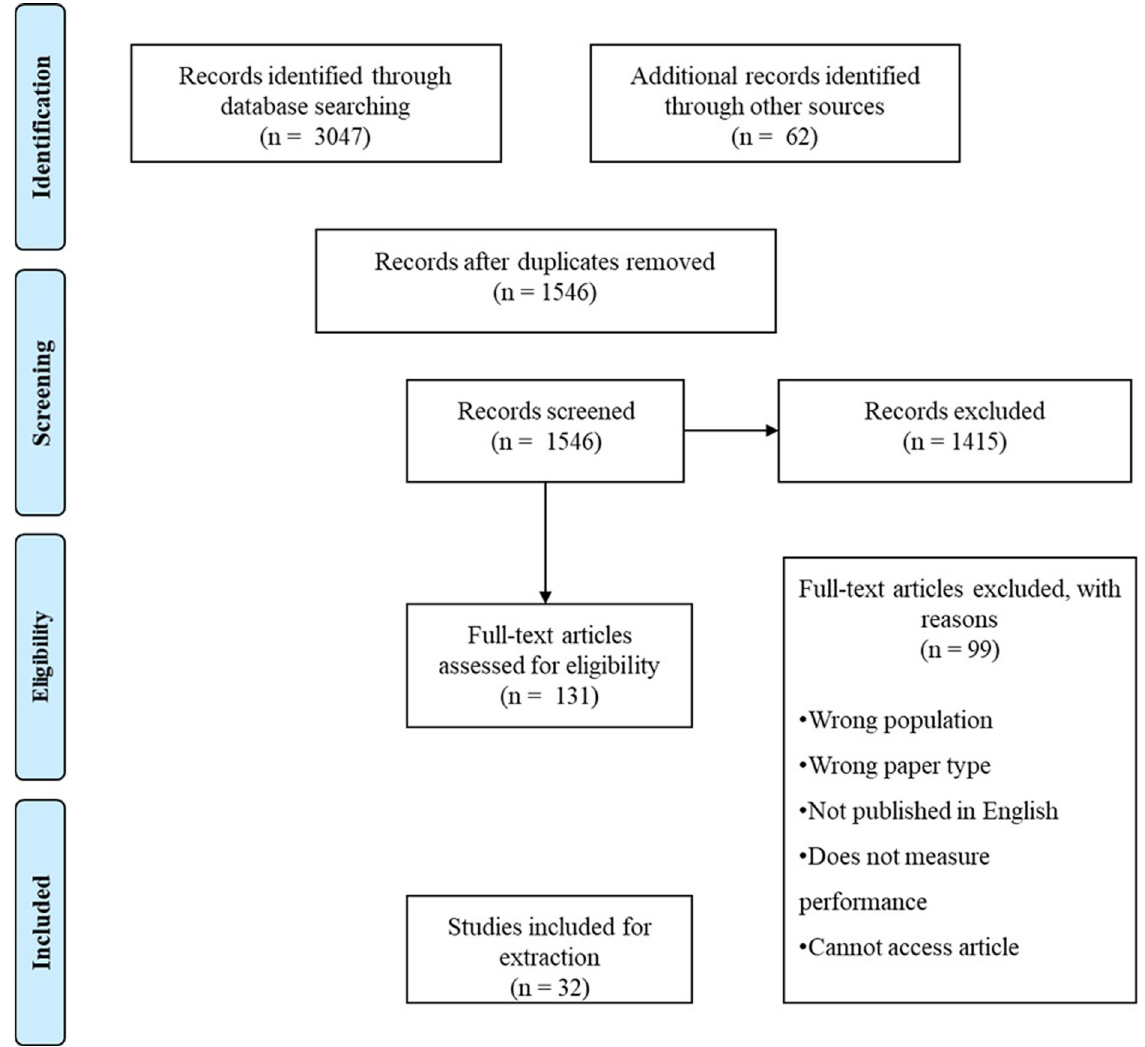
Fig 1. PRISMA flow chart. Flow chart explaining the search process for the systematic